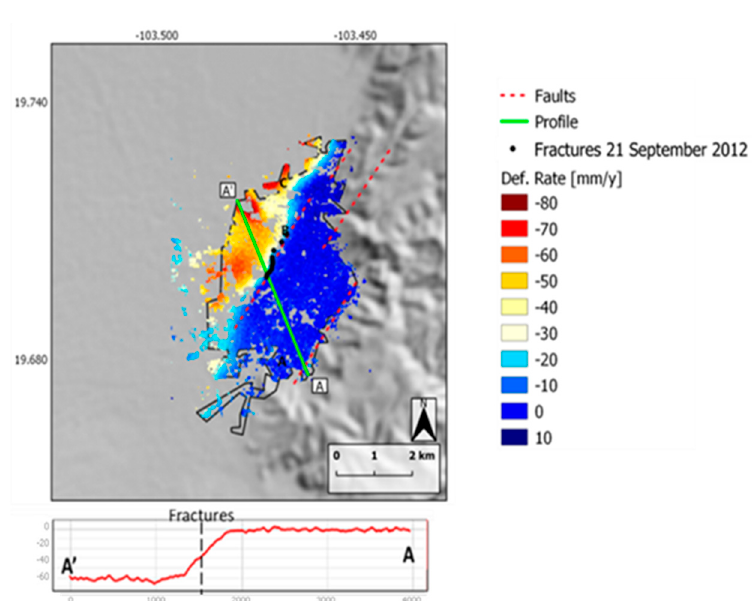
Figure 9. Vertical deformation rate retrieved from S1 ascending and descending data. In the A-A’ velocity profile, the horizontal axis gives the distances (m), the vertical axis the velocities (mm/yr): positive and negative values indicate Eastward and Westward movements respectively.